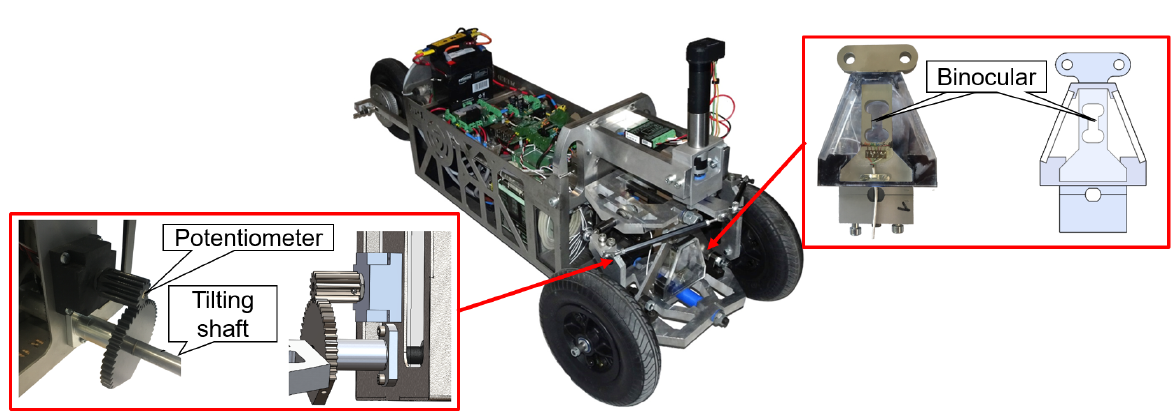
Figure 31. NTV demonstrator and its two main sensors: a rotating potentiometer and a binocular strain gauge for torque measurement.